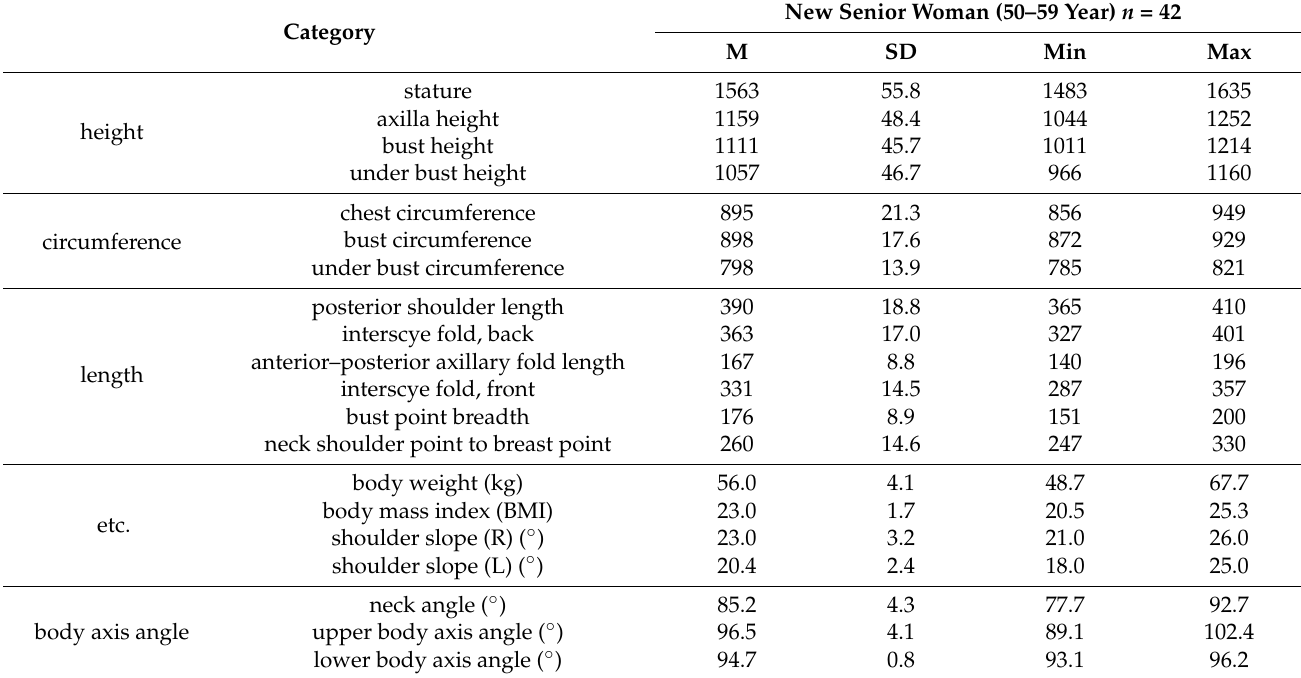
Table 1. Human body dimensions of the target group (size 80A) (Unit: mm, kg, ◦